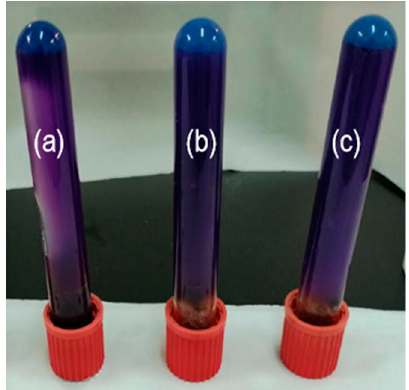
Figure 3. Crosslinking 9% PAM with various concentrations of Co (II): ( a ) 10,000 ppm, ( b ) 12,000 ppm, and ( c ) 13,300 ppm at 130 °C.